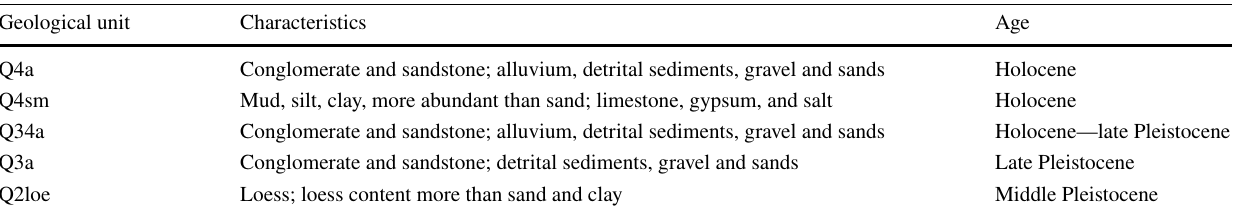
Table 1 Geological units and their characteristics in the study area Geological